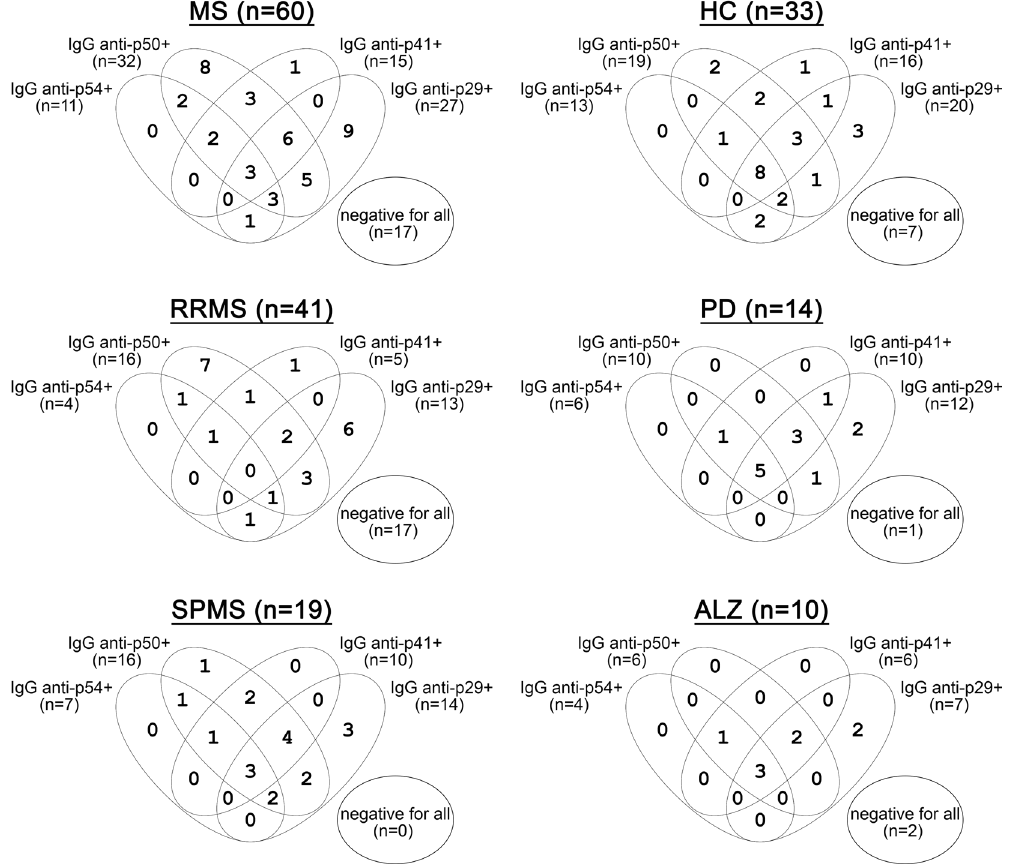
Figure 3. Venn diagrams illustrating the patterns of anti-p54-flagellin, anti-p50, anti-p41 and anti-p29 antibodies overlapping reactivities in patients with MS, RRMS, SPMS, in healthy controls (HC), in patients with Parkinson’s disease (PD) and in patients with Alzheimer’s disease